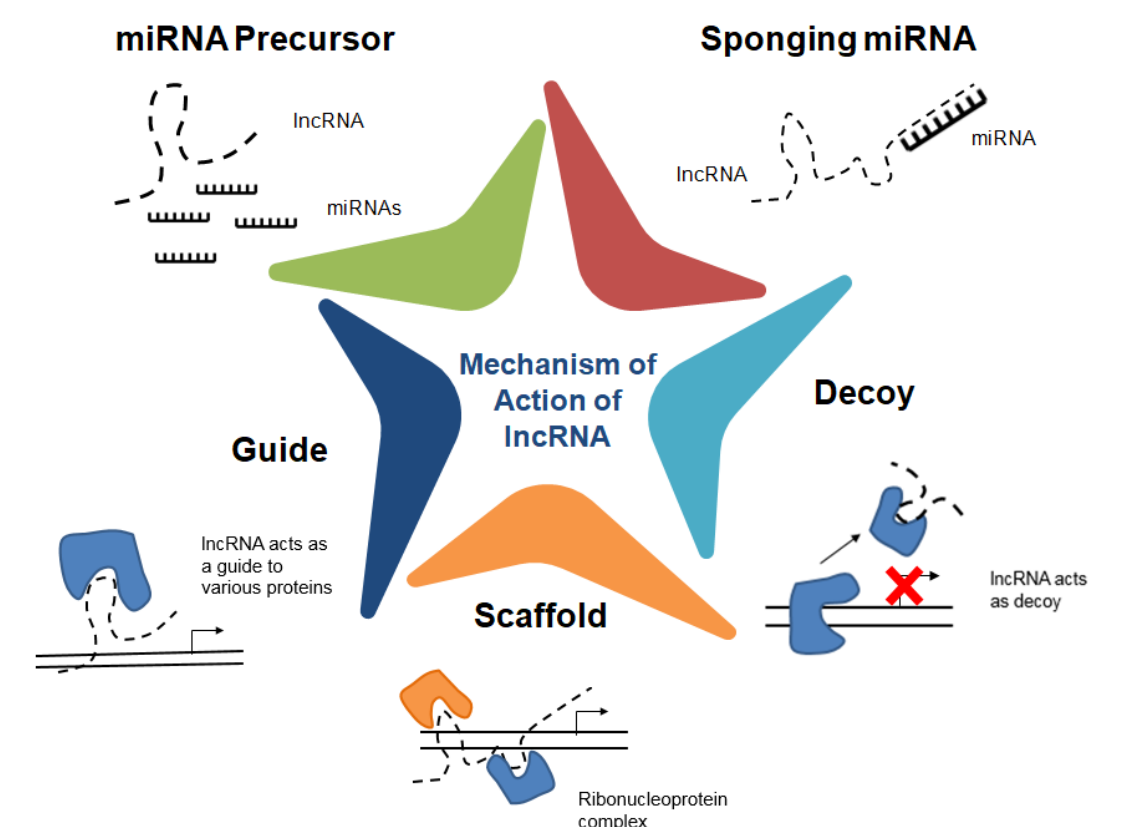
Figure 3. Mechanism of action of lncRNA. LncRNAs regulate gene expressions by acting as guide. They can also act as a scaffold to facilitate the formation of ribonucleoprotein complexes. By acting as a decoy, lncRNA can bind to the transcription factors and remove them from chromatin, thus inhibiting its regulation. LncRNAs can also function as miRNA precursors besides inhibiting miRNA-mediated gene repression by sponging miRNAs.